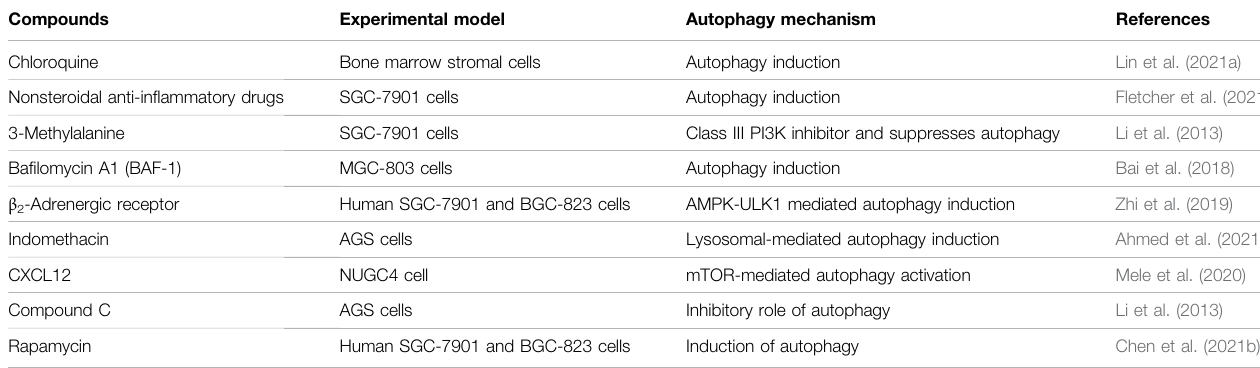
TABLE 1 | Several molecular target and therapeutic role of different drugs in autophagy modulation in gastric cancer cells.